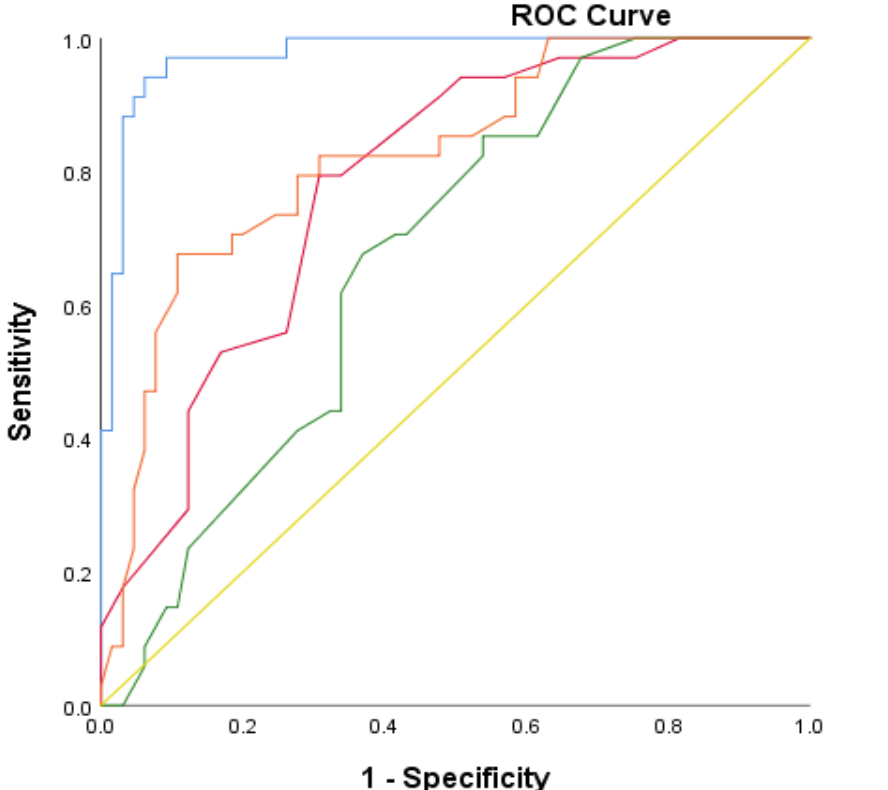
Figure 4. Receiver operating characteristics curve of the ability of PDAss to predict CLD/death.